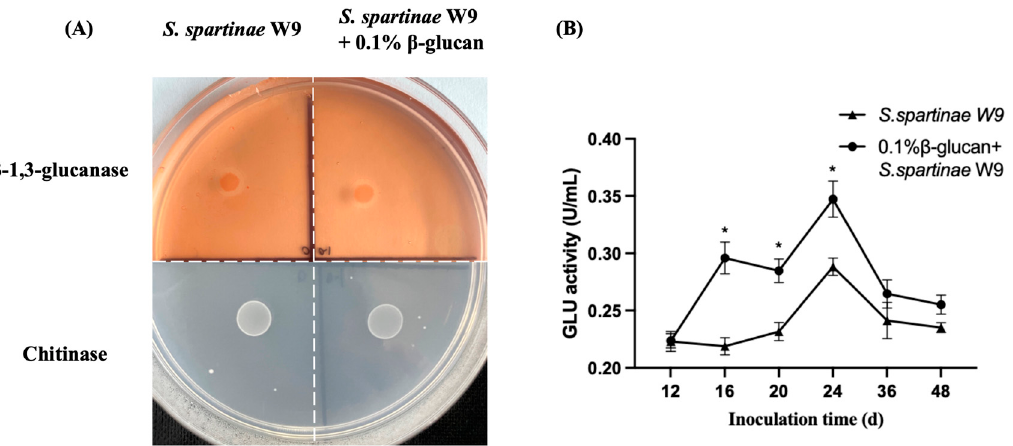
Figure 4. E ff ects of 0.1% β -glucan on extracellular hydrolase activity of S. spartinae W9. ( A ) Results of the extracellular hydrolase assay plates of S. spartinae W9 cultured with or without 0.1% β -glucan. ( B ) GLU activity of S. spartinae W9 cultured in NYDB or NYDB containing 0.1% β -glucan. Asterisks indicate a signi fi cant di ff erence between S. spartinae W9 cultured with or without 0.1% β -glucan identi fi ed by the t-test ( p < 0.05).